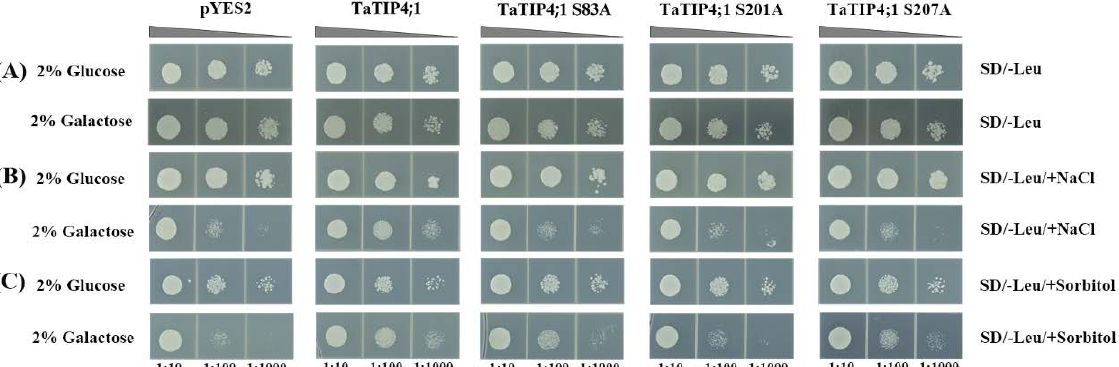
Figure 11. The roles of TaTIP4;1 in yeast. Growth performances of yeast cells of INVSC1 containing normal or mutated TaTIP4;1 genes (at the 247th, 602th, 619th, respectively) in medium (SD/-Leu) supplied without ( A ) or with 50 mM NaCl ( B ) and 200 mM sorbitol ( C ) for 3 days at 30 ◦ C. The reduced cell densities in the dilution series are shown by narrowing triangles when proceeding from left to right. Experiments were repeated three